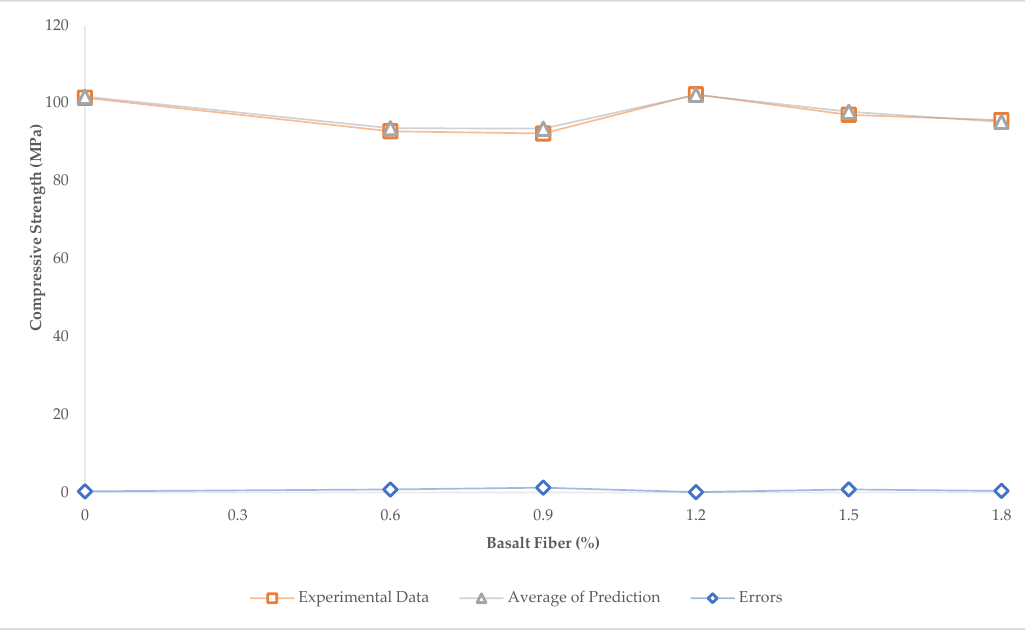
Figure 18. Compressive Strength Average Prediction, Experimental Data, and Errors.